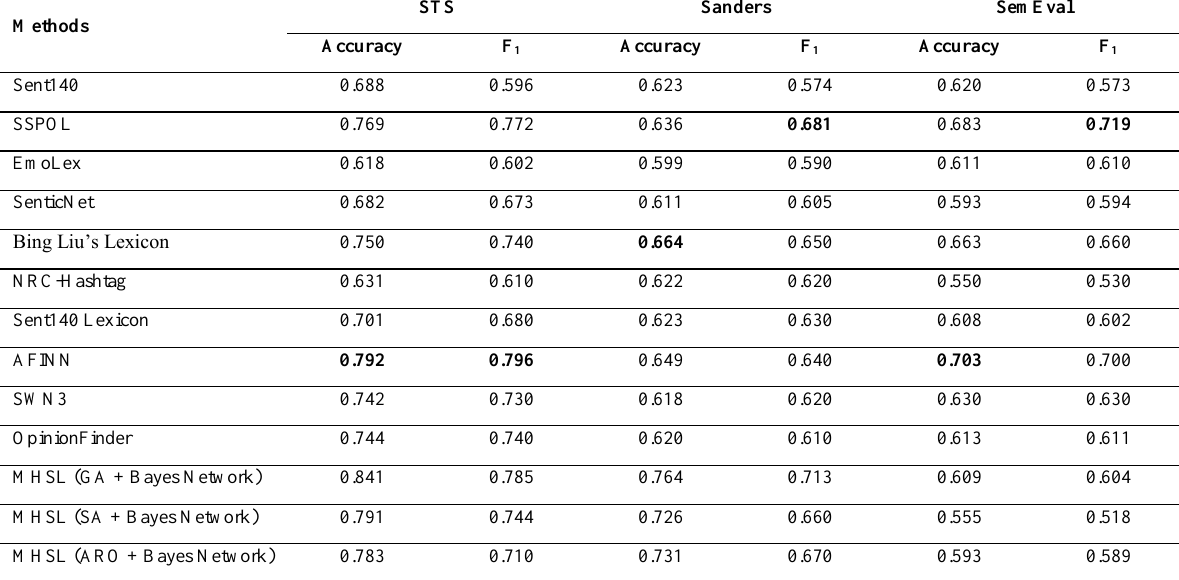
Table 3. 10-fold cross-validation subjectivity classification results